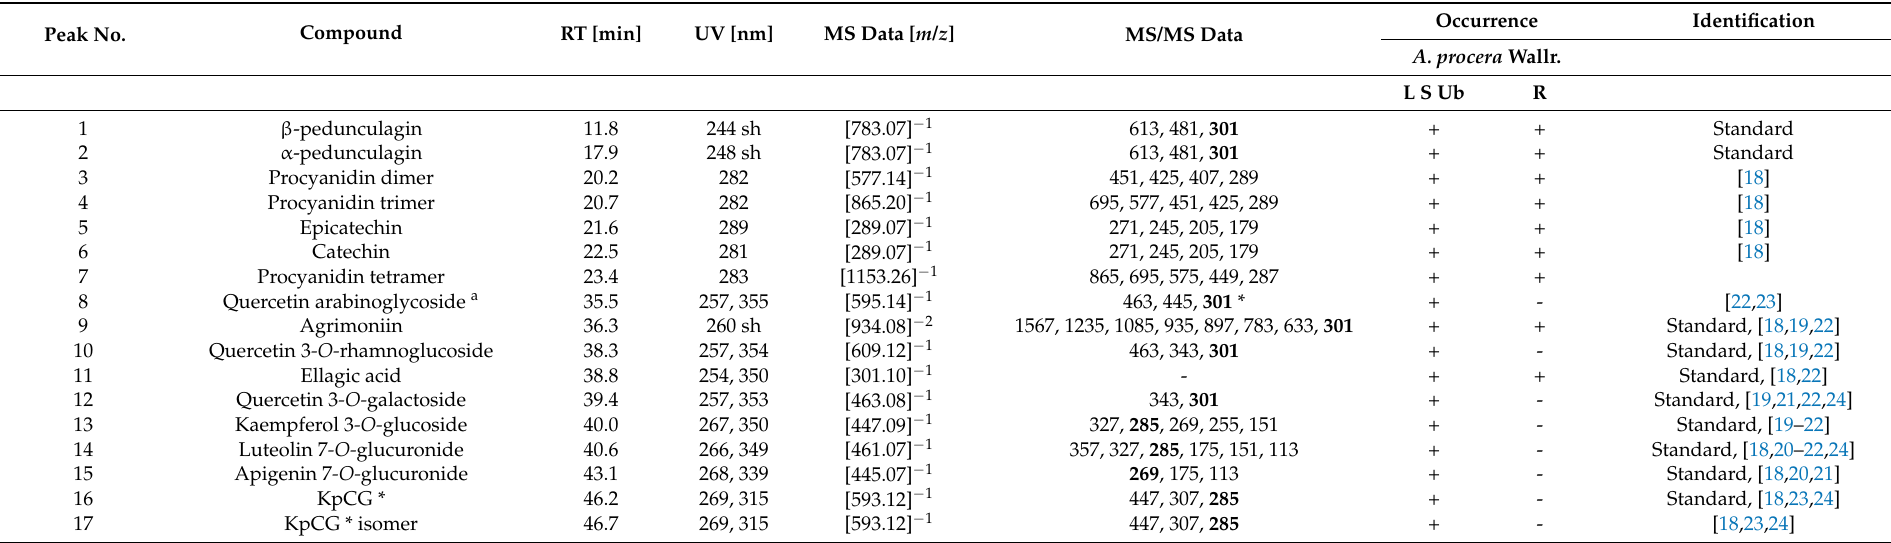
Table 2. LC-MS identification of polyphenols in leaves, stems, fruits, roots, and underground buds of Agrimonia procera Wallr. Peak